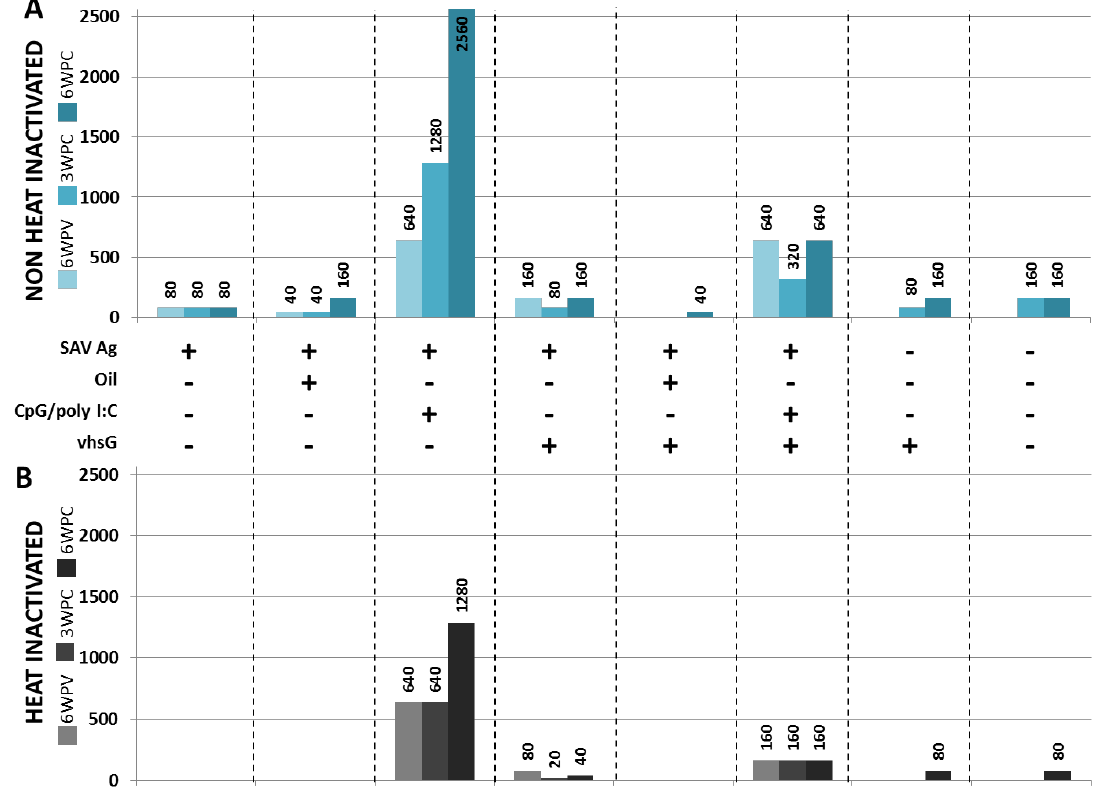
Figure 3. Vaccine-induced anti-SAV neutralizing titres from not heat inactivated ( A ) and heat inactivated ( B ) sera, collected at 6 wpv, 3 wpc and 6 wpc (the colour codes for each time point are next to the y -axis). Titres representing a 50% reduction, calculated as described in the Materials and Methods, are shown above the histogram corresponding to each treatment. + or −, respectively, indicates the presence or absence of either SAV Ag, oil, CpG/polyI:C or